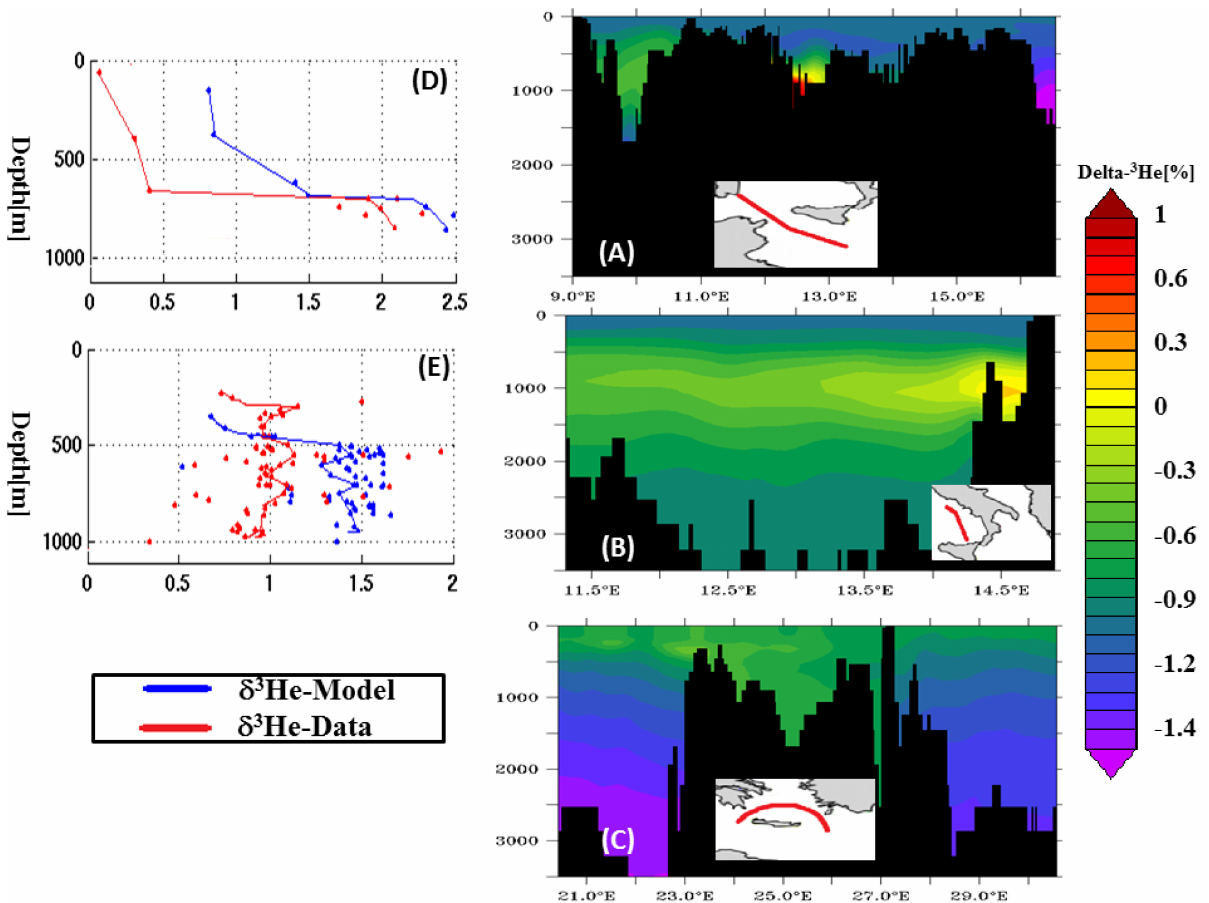
Figure 5. Mantle+atmospheric δ 3 He (%) model–data comparison in (a) the Sicily Channel, (b) Tyrrhenian sub-basin, and (c) Aegean sub- basin. (d) Vertical profiles of δ 3 He (above the atmospheric background of − 1.6%) at 12.5 ◦ E in the Sicily Channel; model results are in blue; red indicates in situ data (Fourré and Jean-Baptiste, unpublished results). (e) : same as (d) for the Tyrrhenian sub-basin. The data are from Lupton et al. (2011). The few stations located right above a plume in Lupton et al. (2011) have been discarded because they cannot be compared to model results which are averaged over the volume of the model cell ( ∼ 20km 3 ). There are no data for the Aegean